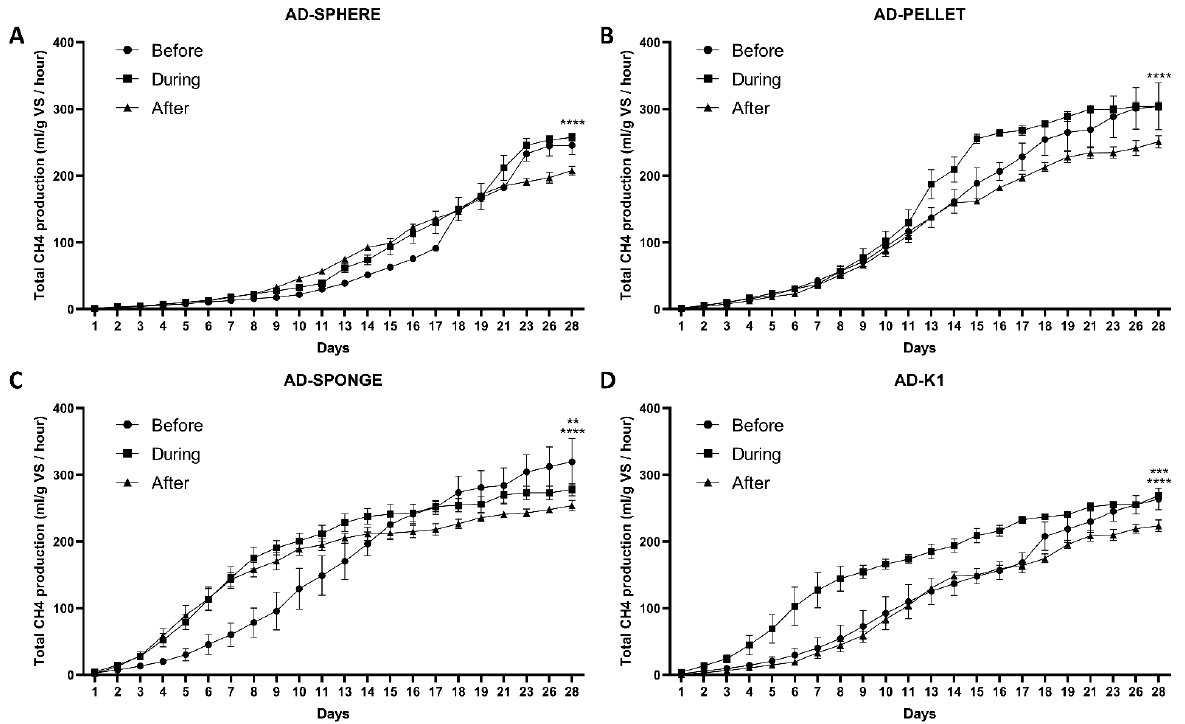
Figure 1. Total CH 4 production of commercial biocarriers on day 3 ‘Before’ exponential phase, day 10 ‘During’ exponential phase, day 25 ‘After’ exponential phase. ( A ) Total CH 4 production of AD-SPHERE, ( B ) Total CH 4 production of AD-PELLET, ( C ) Total CH 4 production of AD-SPONGE, ( D ) Total CH 4 production of AD-K1. **** p < 0.0001; *** p < 0.001; ** p < 0.01. n = 3.